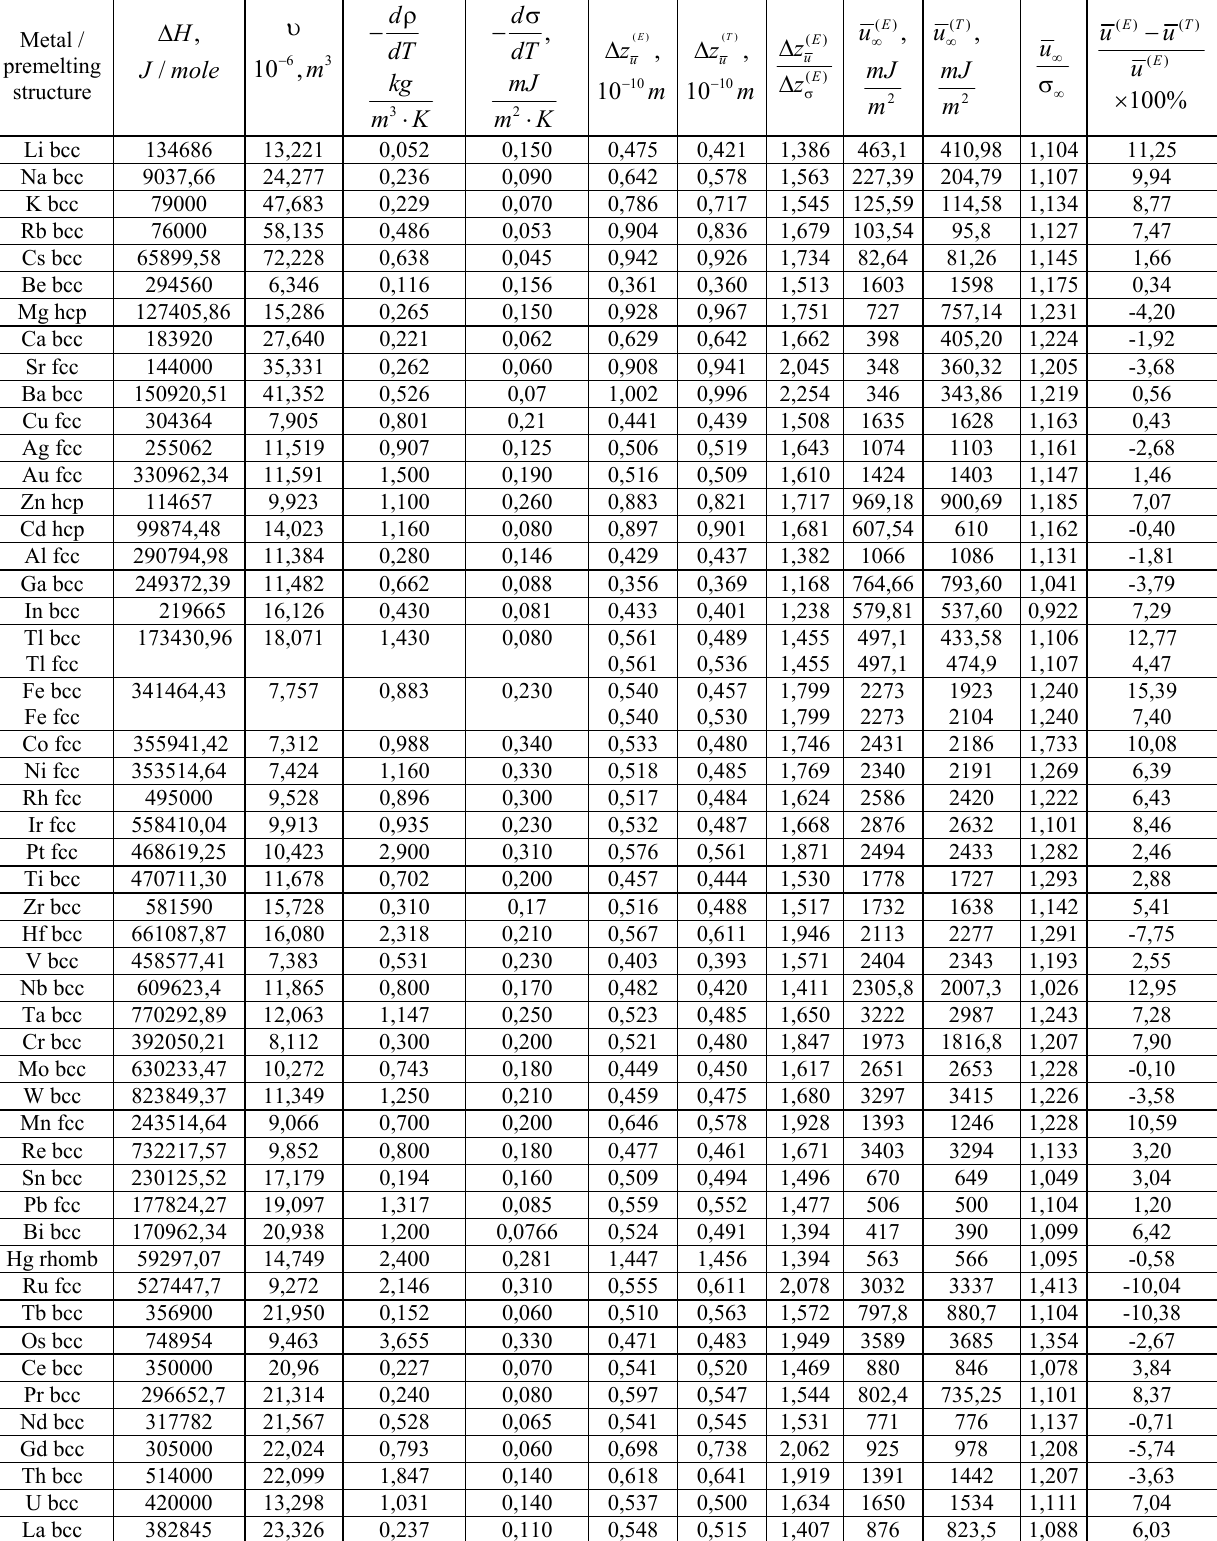
z  , z  , surface energy u u 